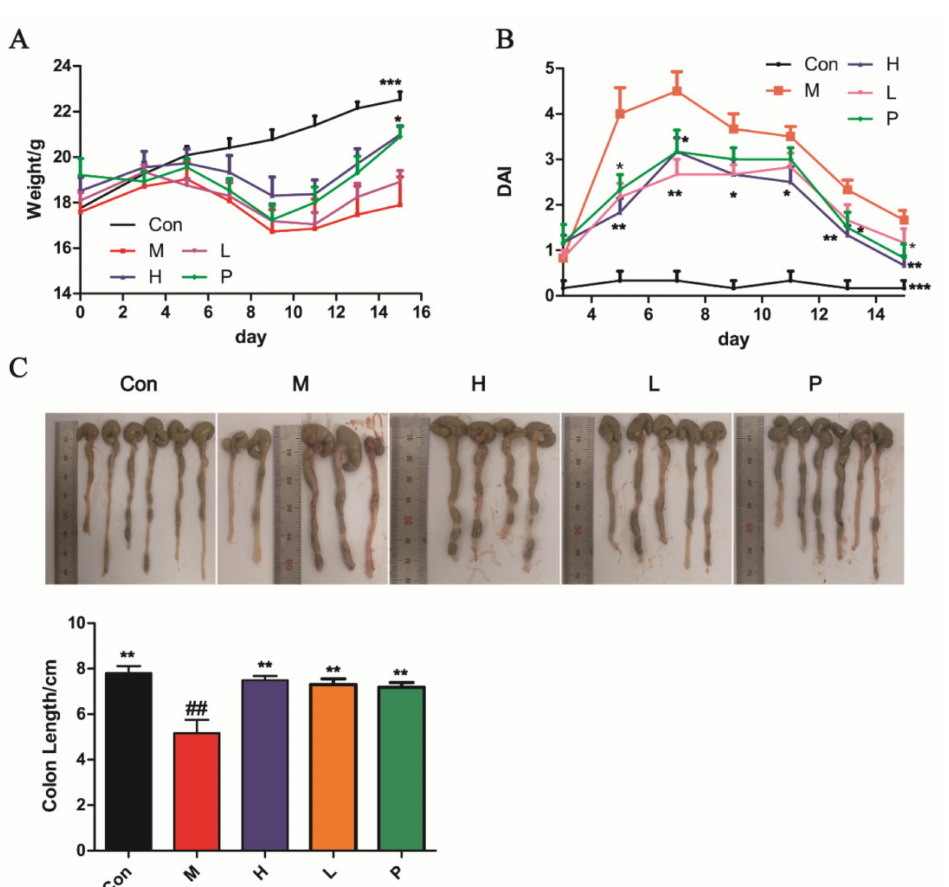
Figure 4. OPA alleviated the clinical symptoms of DSS-induced colitis. ( A ) The change of body weight during 14 days; ( B ) DAI; ( C ) colon length. Con was control group, M was model group, H was the high dose OPA group, L was low dose OPA group, P was positive group. Data were expressed as the mean ± SD ( n = 6), the statistical analyses were done with t -test; *** p < 0.001, ** p < 0.01, * p < 0.05 compared with the model group; ## p < 0.01, compared with the control